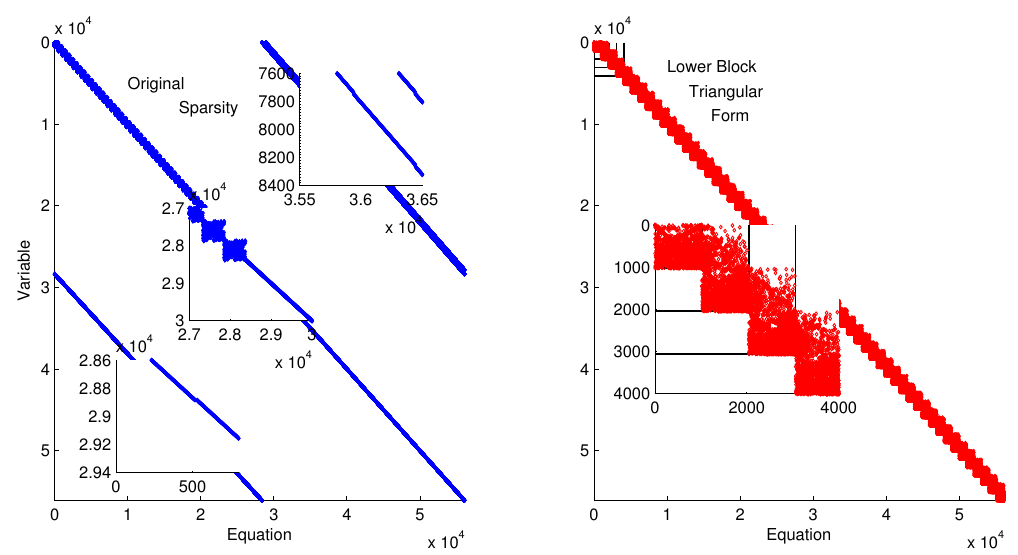
Figure 11. Lower block triangular form of ErbB model with original sparsity on the left and rearranged sparsity with successive blocks of variables and equations that are solved successively.